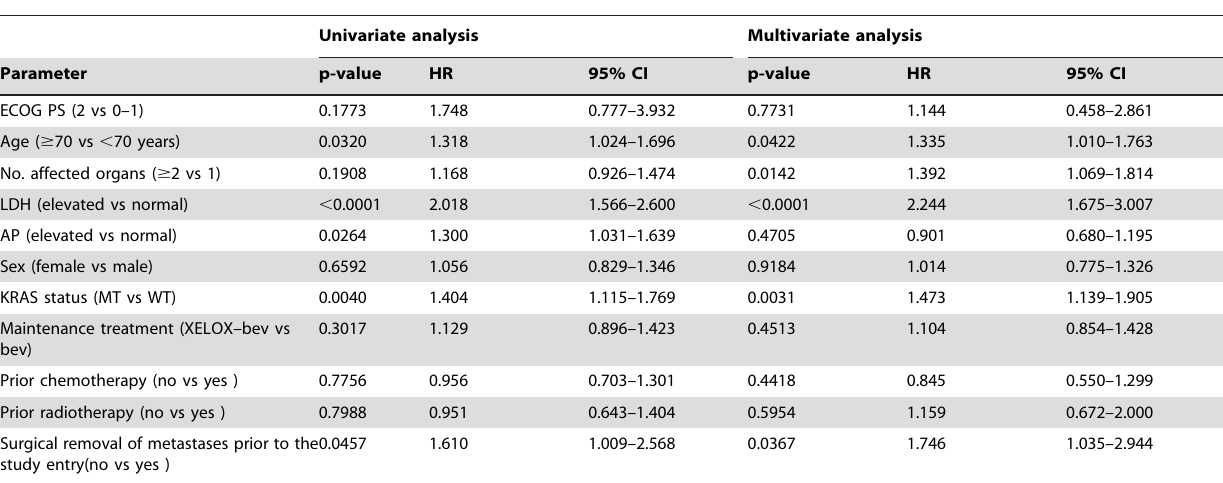
Table 3. Univariate and multivariate analyses for progression-free survival.